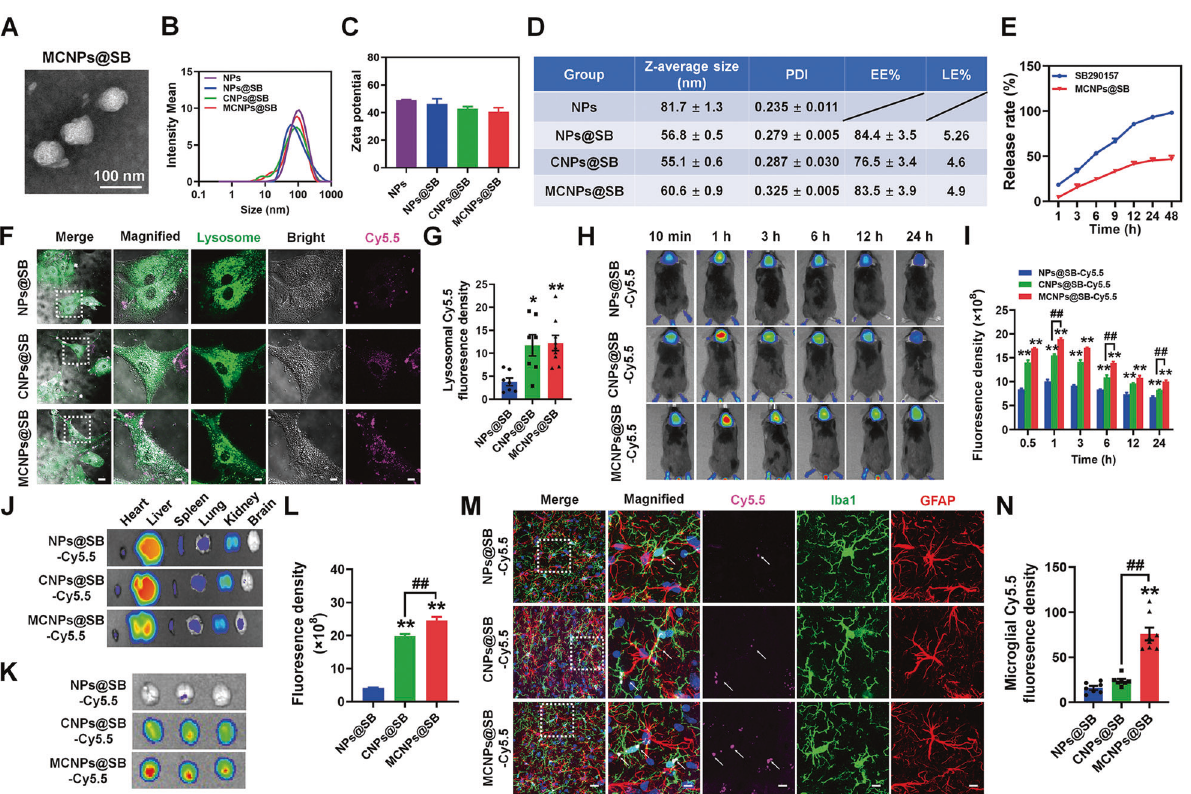
Fig. 7 Establishment of the microglial C3aR antagonist delivery system. A Representative TEM images of MCNPs@SB. Scale bars: 100 nm. B , C Particle size and Zeta potential analysis of NPs, NPs@SB, CNPs@SB, and MCNPs@SB; n = 3 per group. D Z-average size, PDI, EE% and LE%